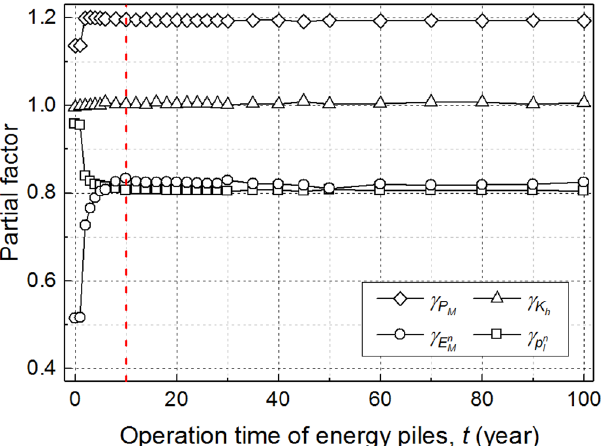
Figure 9. Effect of operation time of energy piles on calibrated partial factors.